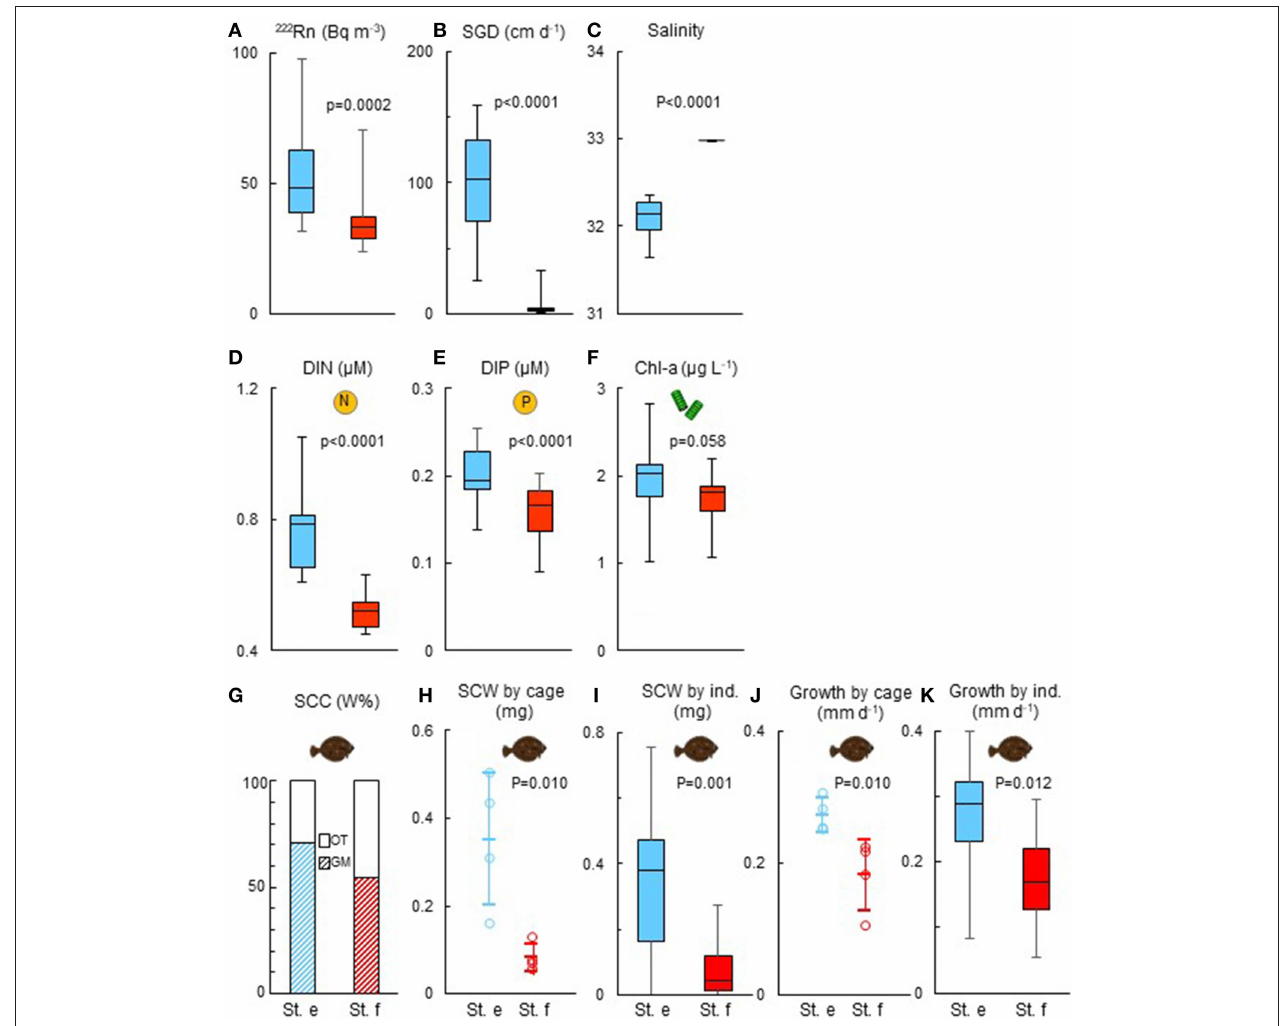
FIGURE 4 | Comparisons of 222 Rn (A) , submarine groundwater discharge (SGD: B ), salinity (C) , dissolved inorganic nitrogen (DIN) (D) , dissolved inorganic phosphorus (DIP) (E) , and chlorophyll-a (Chl-a: F ) concentrations monitored every hour for 24h at sts. e and f in survey site III. Juvenile stomach content composition (SCC, weight%: G ), stomach content weight (SCW) by cage (H) and individual fish (I) , and growth for 2 weeks by cage (J) and individual fish (K) were compared between the two stations at the end of the cage experiment. Vertical bars and boxes (A–F,I,K) indicate every 25% range of the data. Circles (H,J) indicate each data and bars show mean and standard deviation. The p value of statistical analysis for comparison between the two stations is presented for each panel (Student’s t -test for A–F,I,K ; Mann–Whitney U -test for H,J ). Hourly data from Nakajima et al. (2018) were processed for panels (A–C) in the present study in order to provide evidence of SGD signal at the survey